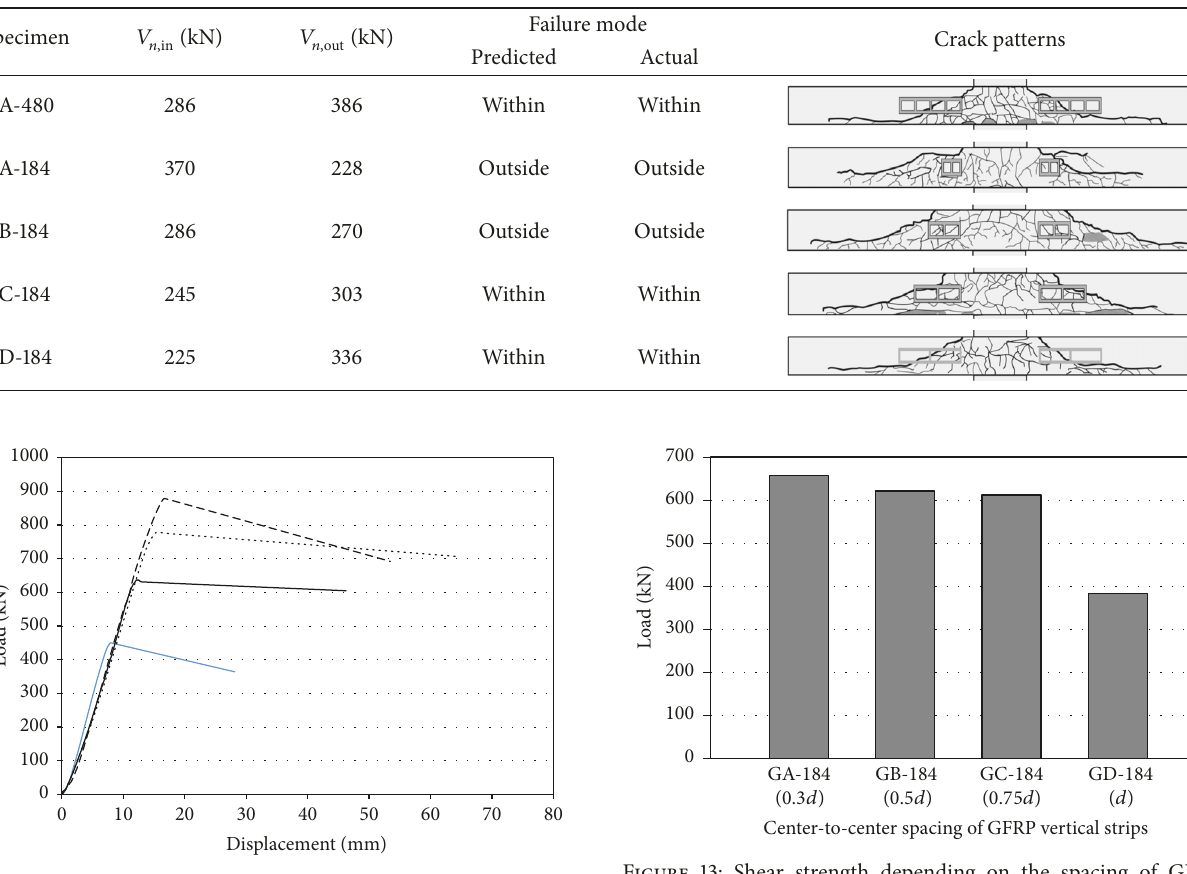
Table 4: Failure modes.